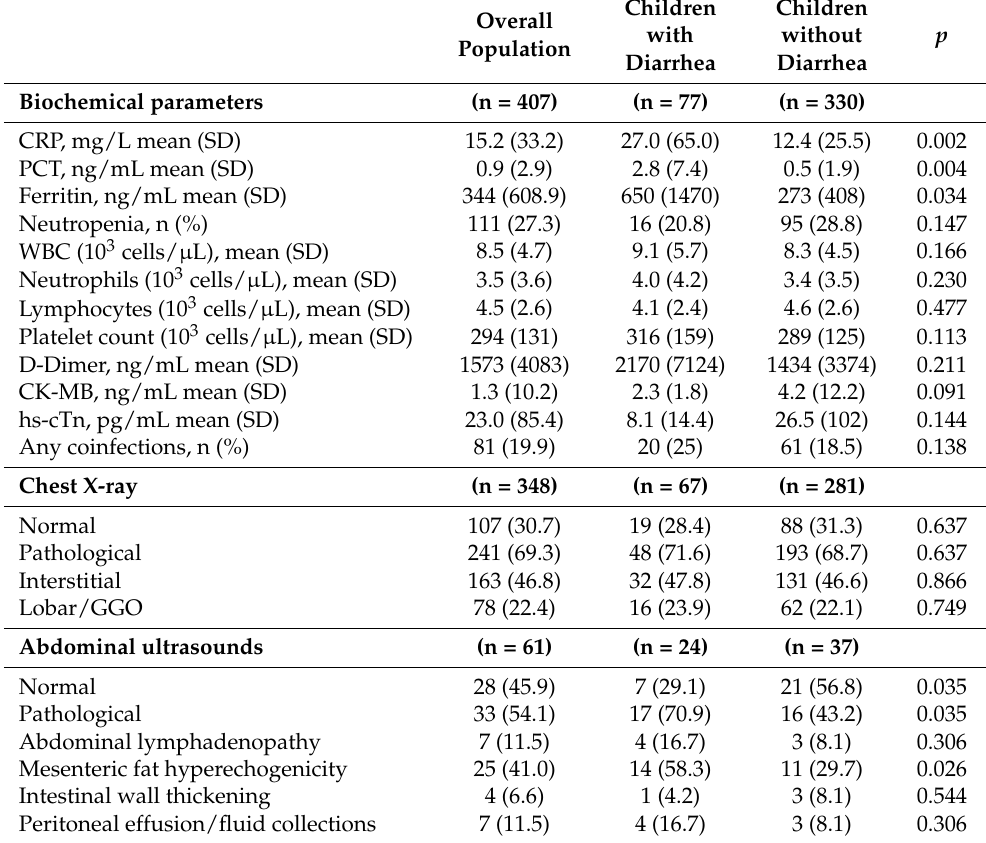
Table 3. Biochemical and radiological features of enrolled children.